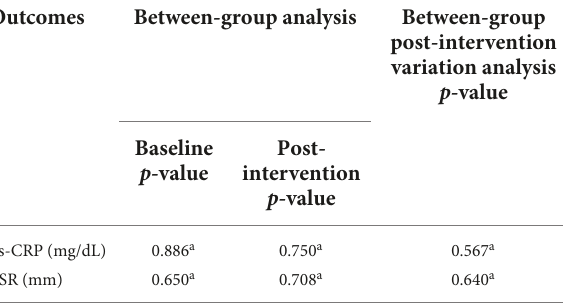
TABLE 7 Between-group analysis of biochemical